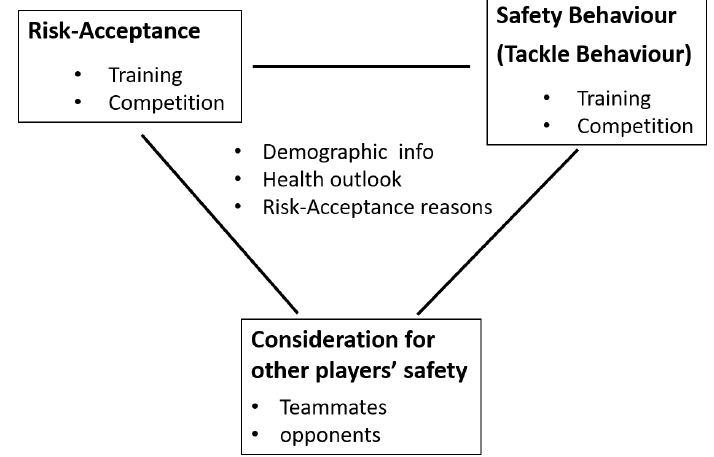
Figure 1. Player safety awareness